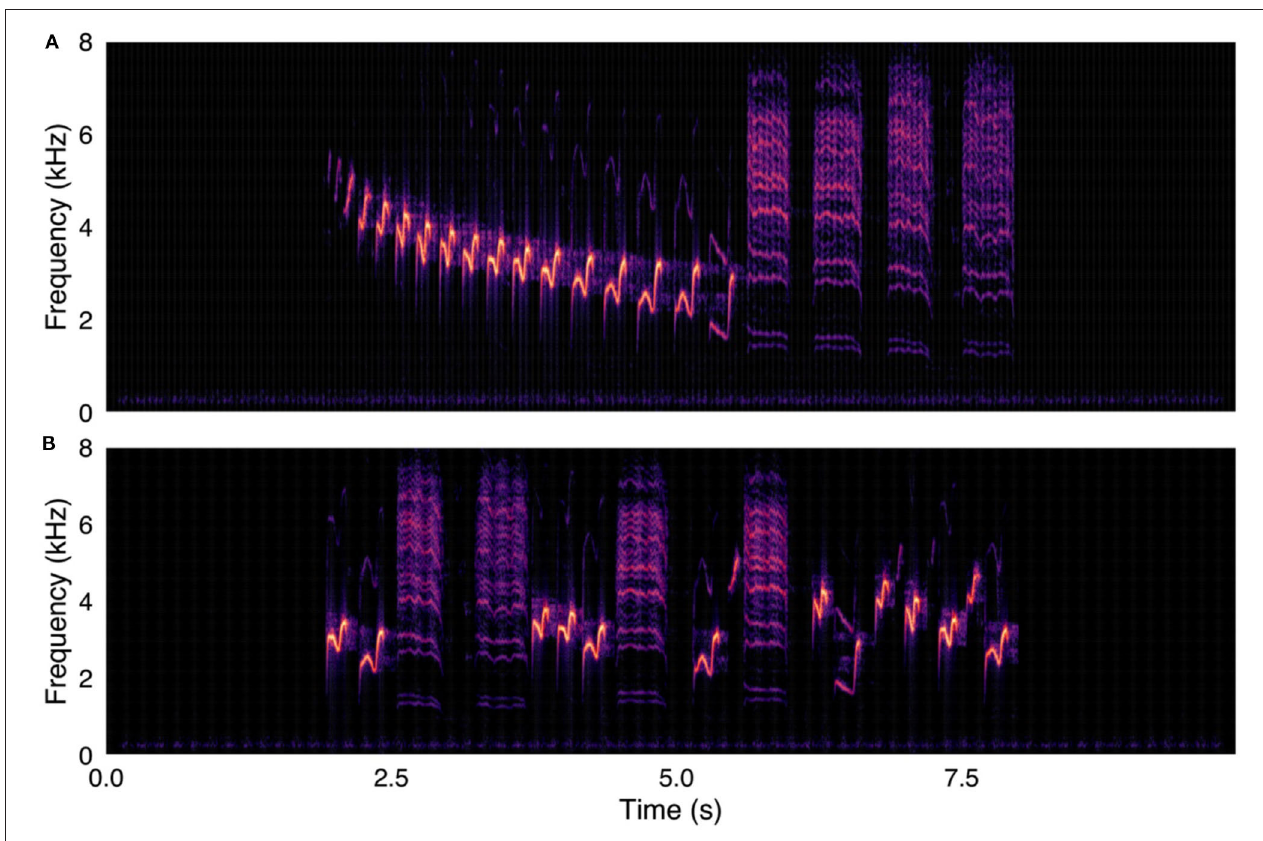
FIGURE 1 | ( A , upper panel) Canyon wren ( Catherpes mexicanus ) recording used in survey, with song elements in original temporal order. ( B , lower panel) Same Canyon wren recording, with song elements in randomized temporal order. Spectrograms were created with were created using a 1024-point FFT and a Hamming window with 87.5%